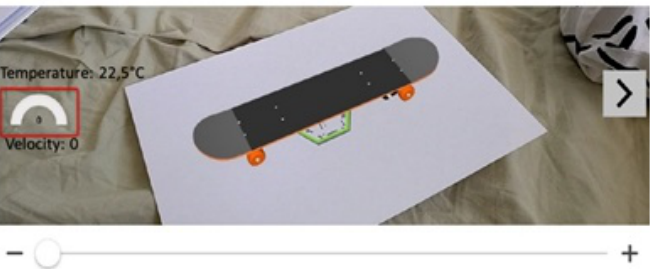
Fig. 6. Augmented sensor